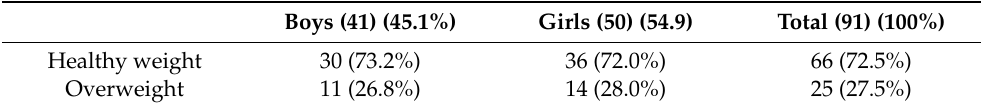
Table 1. Distribution of the sample according to gender and